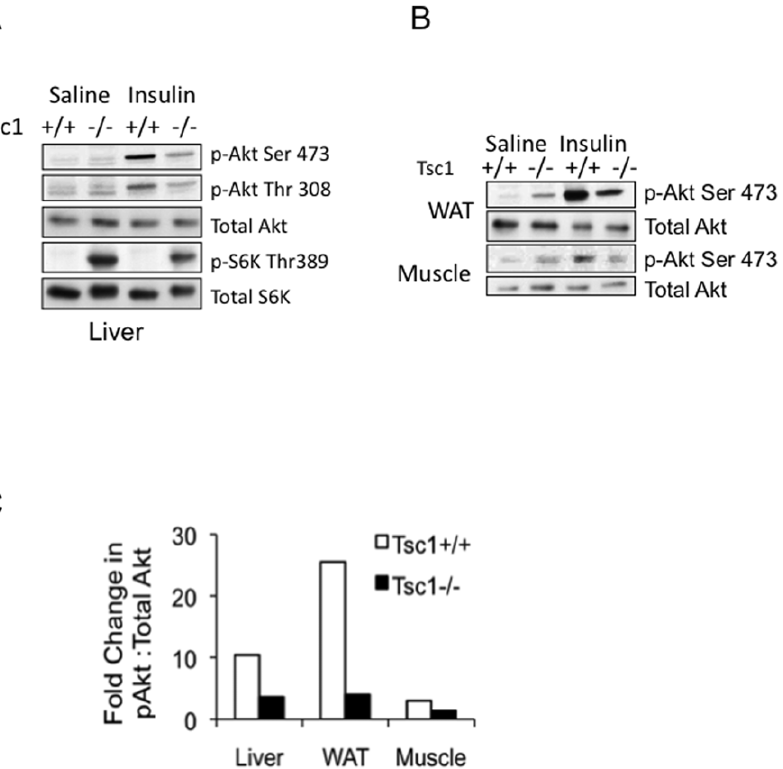
Figure 2. Liver, fat and muscle of Tsc1 2 / 2 mice show blunted response to insulin. Following an eight-hour fast, mice were injected with 0.5 U/kg of insulin or saline (control) for 10 minutes before sacrifice. A) Liver and B) white adipose tissue (WAT) and skeletal muscle tissue lysates were analyzed for the expression of indicated proteins. C. Akt response to insulin. The relative band intensities of p-Akt(Ser473) were normalized to total Akt from (A) and (B), and then the ratios between the insulin- and saline-treated animals were calculated from individual tissues tested.